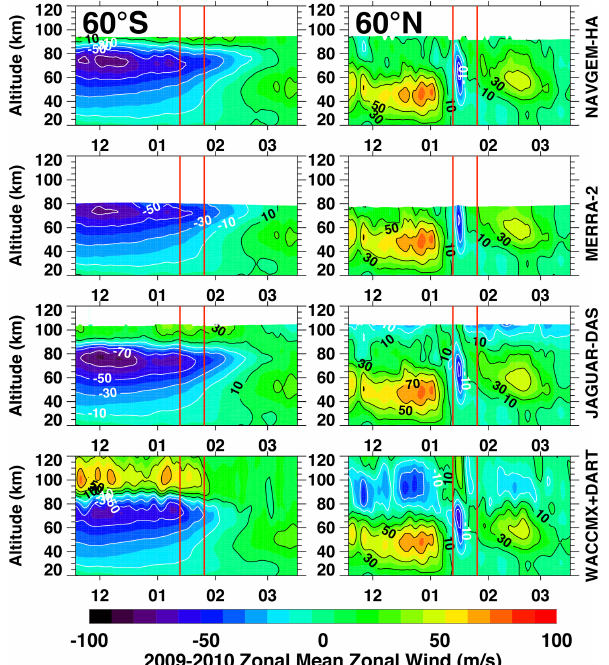
Figure 6. As in Fig. 5 but for zonal wind at 60 ◦ S (left) and 60 ◦ N (right).